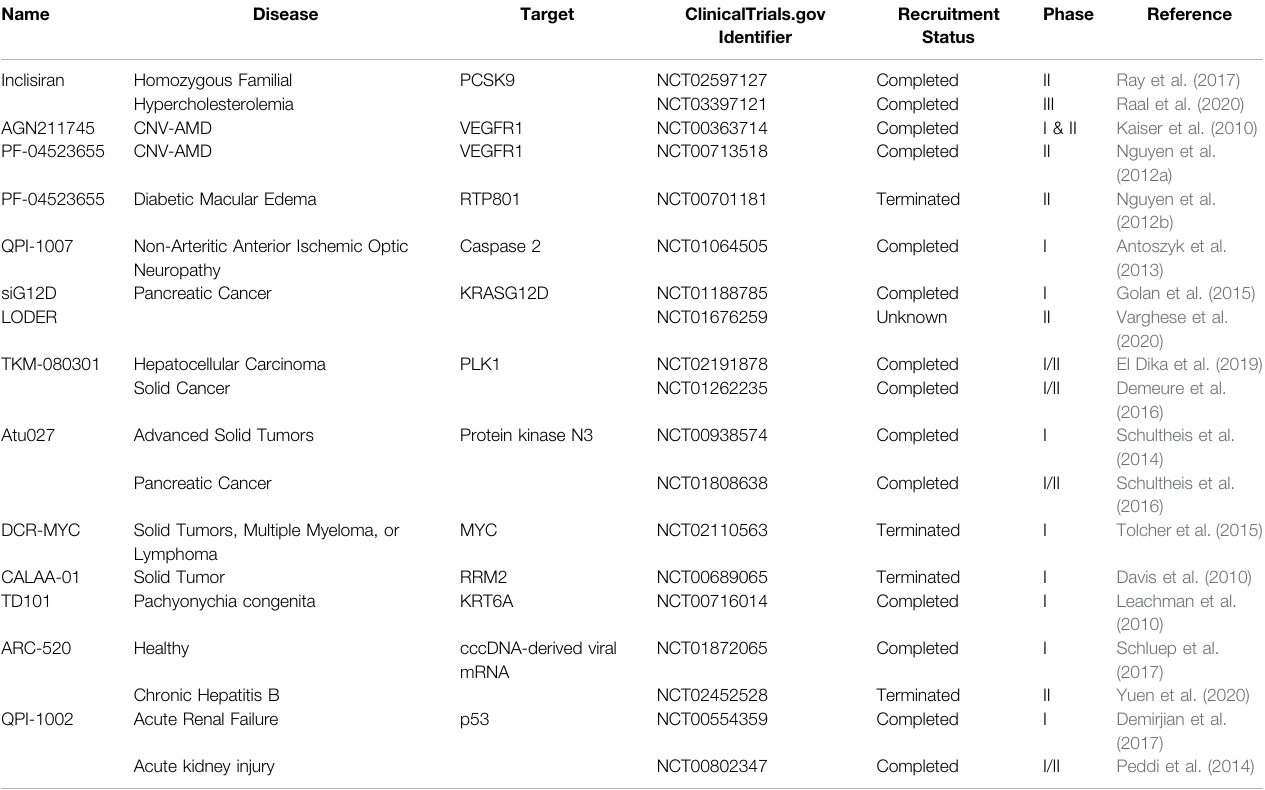
TABLE 1 | siRNA therapeutic applications in clinical